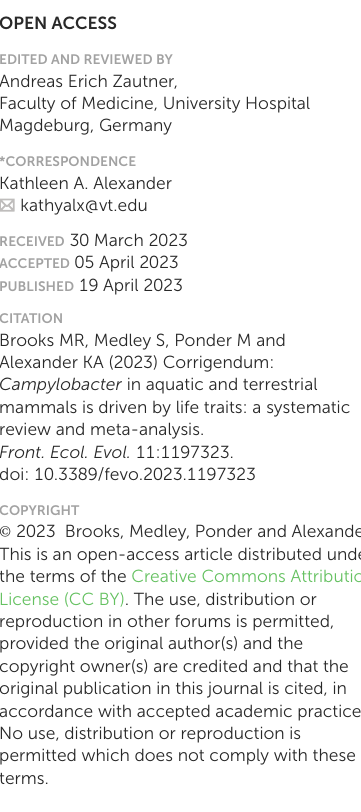
Figure 1. Probability of Campylobacter carriage at different trophic levels. Figure 2. Probability of C. jejuni carriage at different trophic levels and degrees of urban